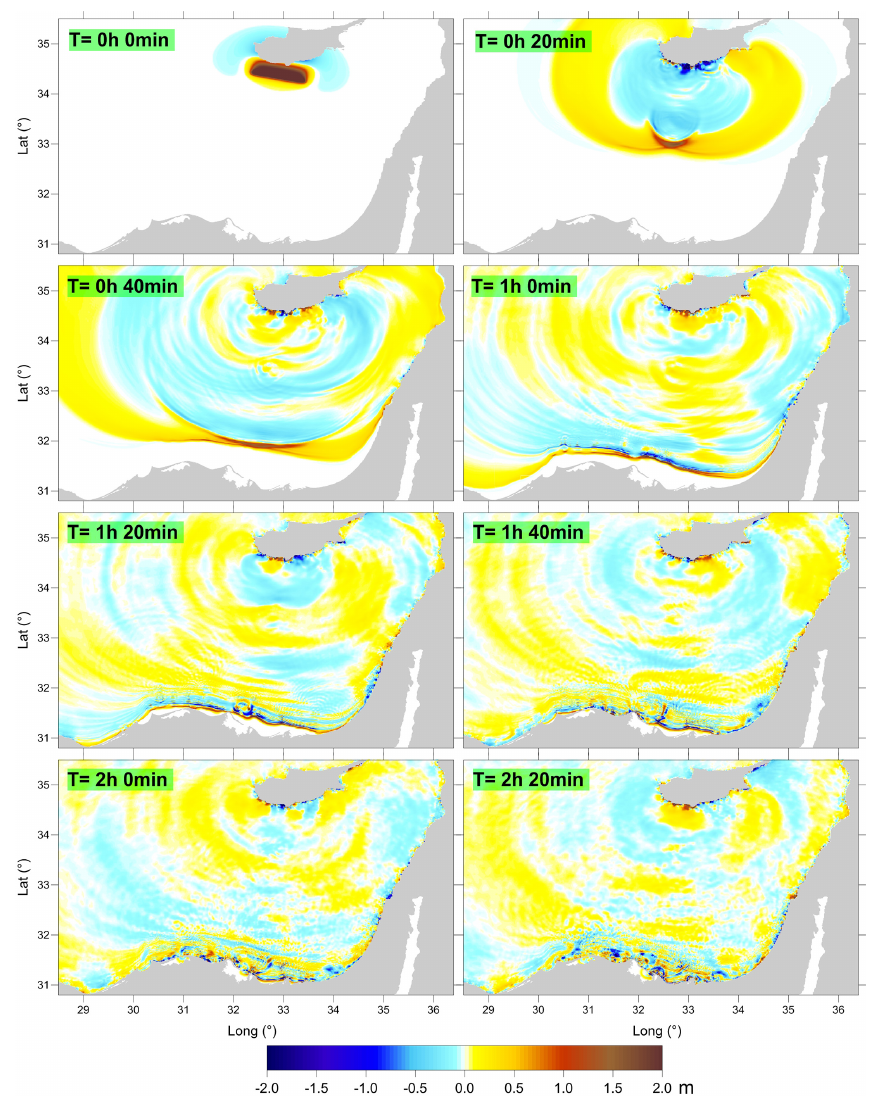
Figure 13. Propagation fields for the CA tsunami scenario. Snapshots taken every 20min. All fields are plotted in grid